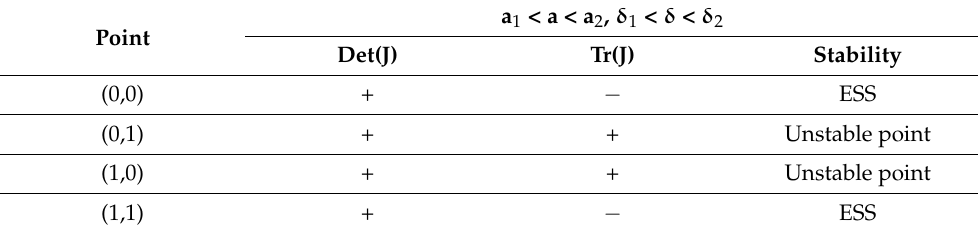
Table 10. Stability analysis of the points in case (4).